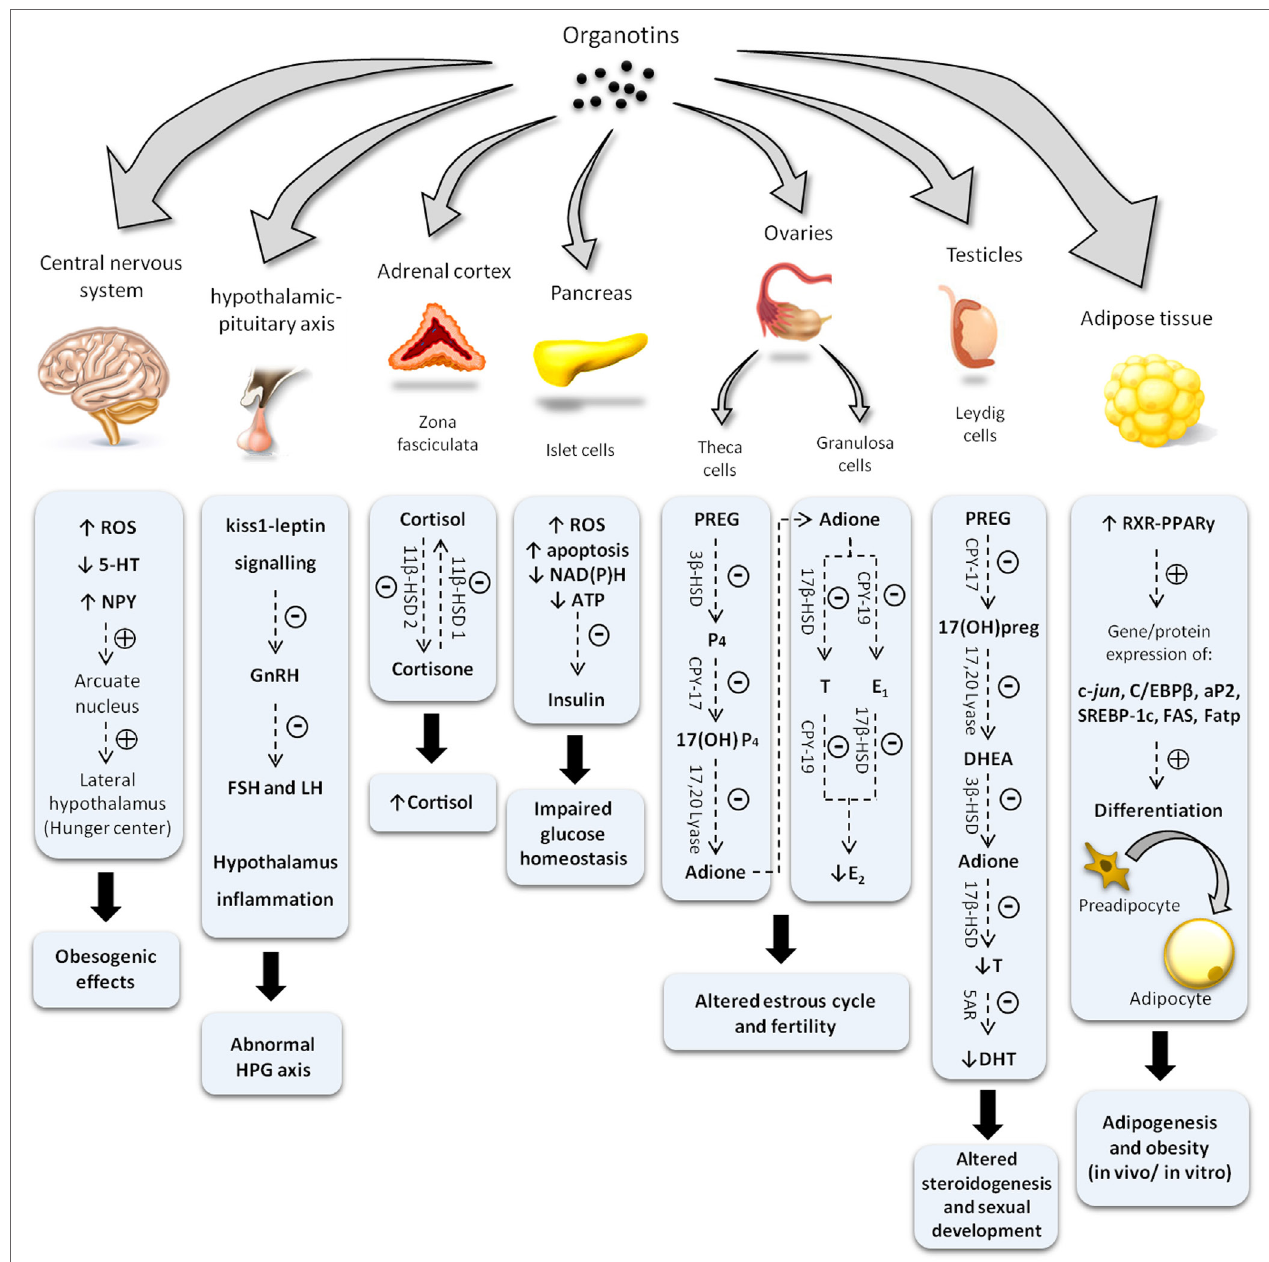
FigURe 2 | Diagram illustrating changes in endocrine system induced by organotin and major mechanisms involved. Symbols ( − ) or ( + ) indicate inhibitory and stimulatory effects, respectively. ROS, reactive oxygen species; 5-HT, serotonine; NPY, neuropeptide Y; GnRH, gonadotropin-releasing hormone; FSH, follicle- stimulating hormone; LH, luteinizing hormone; HPG, hypothalamus–pituitary–gonad; ATP, adenosine triphosphate; NAD(P)H, nicotinamide adenine dinucleotide phosphate; 11 β -HSD, 11 β -hydroxysteroid dehydrogenase; PREG, pregnenolone; 3 β -HSD, 3 β -hydroxysteroid dehydrogenase; P4, progesterone; E1, estrone; E2, 17- β estradiol; T, testosterone; CPY-17, 17 α -hydroxylase; Adione, androstenedione; CPY-19, aromatase; 17(OH)preg, 17(OH) pregnenolone; DHEA, dehydroepiandrosterone; 5AR, 5 α -reductase; DHT, dihydrotestosterone; C/EBP β , CCAAT/enhancer binding proteins; SREBP-1c, sterol regulatory element-binding protein 1c; aP2, adipocyte-protein 2; FAS, fatty acid synthase; Fatp, fatty acid transport proteins.